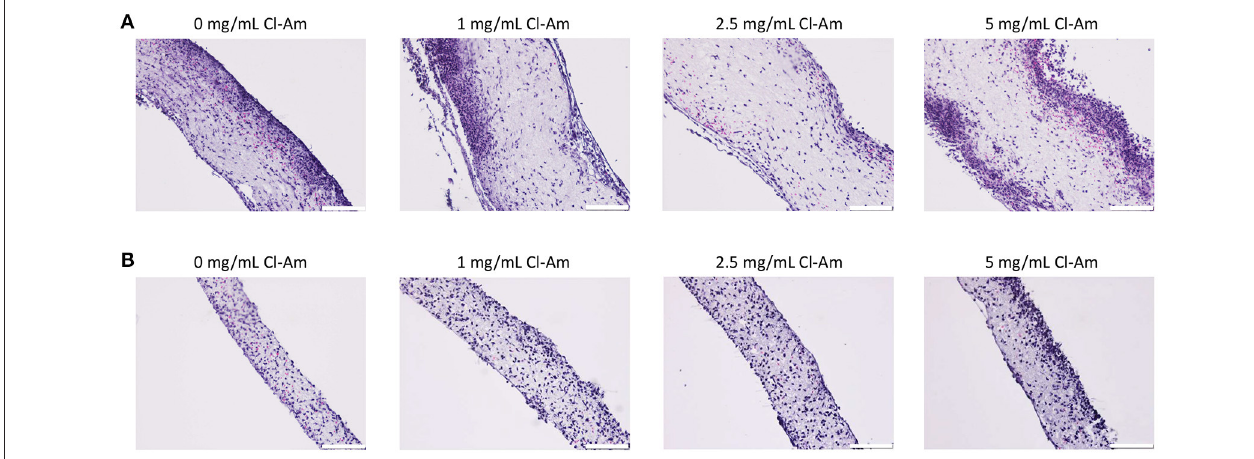
FIGURE 9 | Cl-Am eluting electrospun templates modulate neutrophil behavior in vivo . Representative light microscopy images of H&E stained sections of (A) SD and (B) LD templates removed after 1 day (scale bars = 100 µ